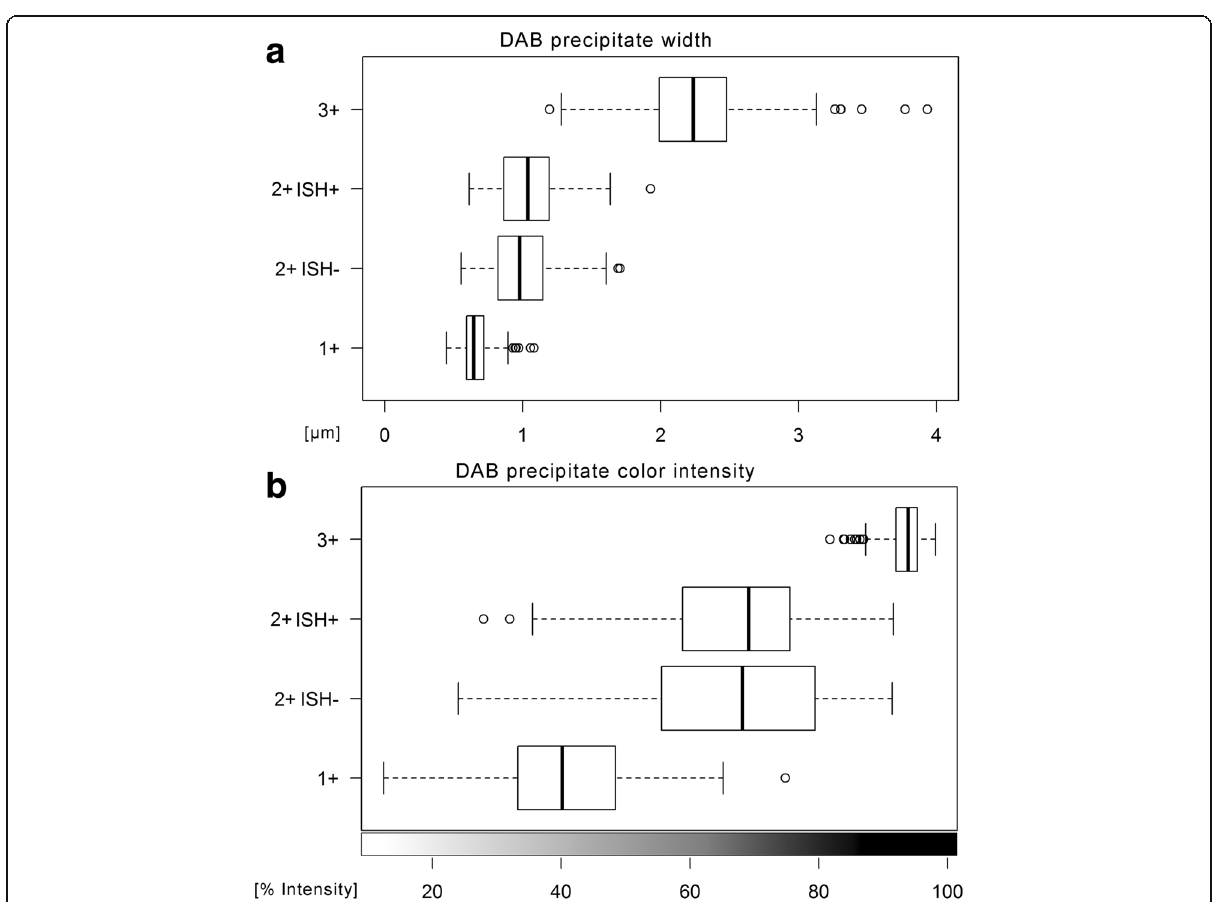
Fig. 2 Width and color intensity of HER2 are correlated. Immunohistochemistry of n =120 cases of invasive ductal carcinoma of the mammary gland show that width of the linear DAB precipitates ( a ) and DAB color intensity ( b ) are correlated (8bit scale, inverted relative values). However, neither parameter discriminates IHC Score 2+ samples that are Her2 amplified (ISH+) or not amplified (ISH-) by in situ